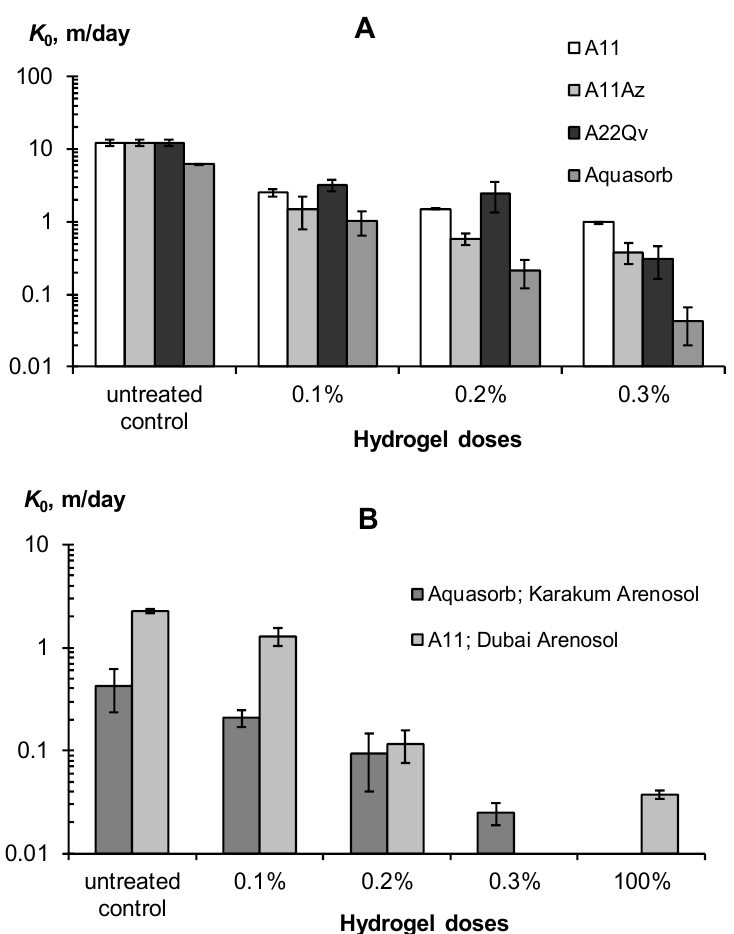
Figure 9. Effect of hydrogels on saturated hydraulic conductivity of coarse-textured soil substrates. ( A ) — monomineral sandy substrates; ( B ) — polymineral loamy-sandy Arenosols.